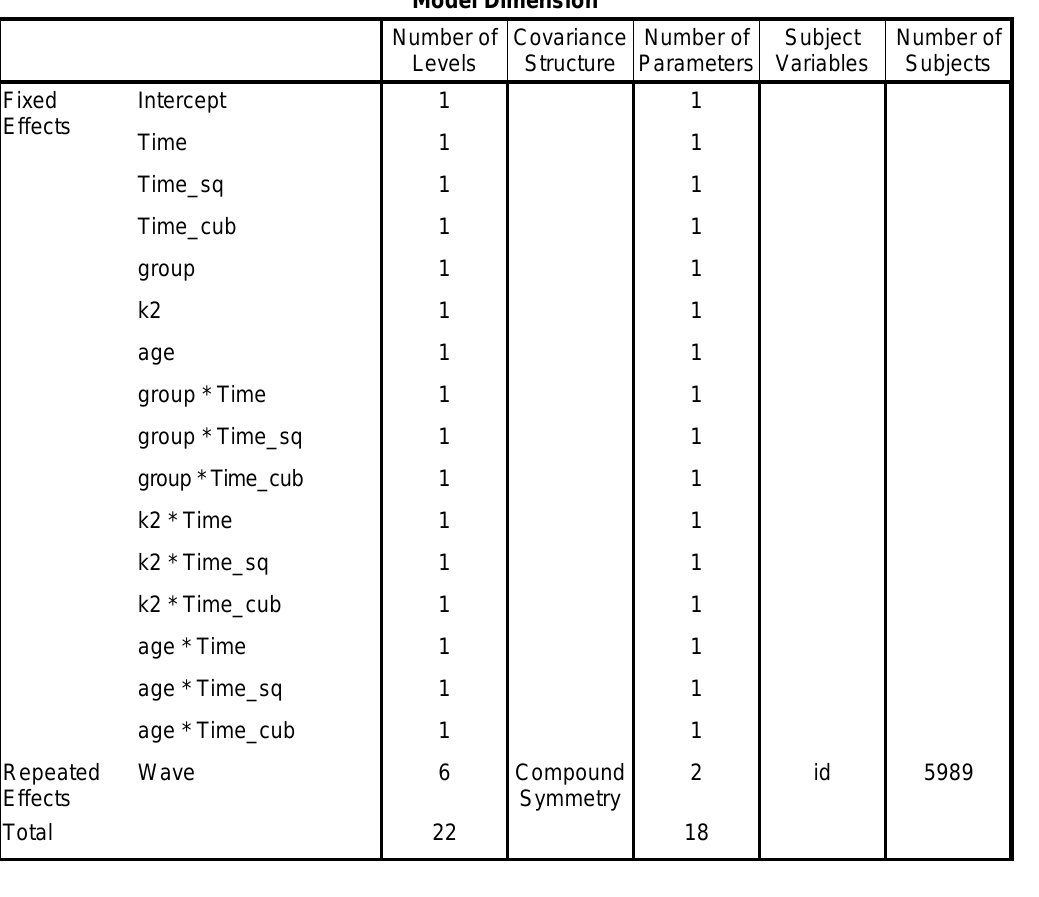
Model 7: Testing Error Structure Covariance Structure (Compound